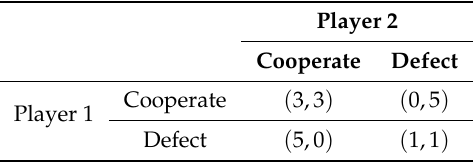
Table 2. Numerical payoff matrix for the prisoner’s dilemma